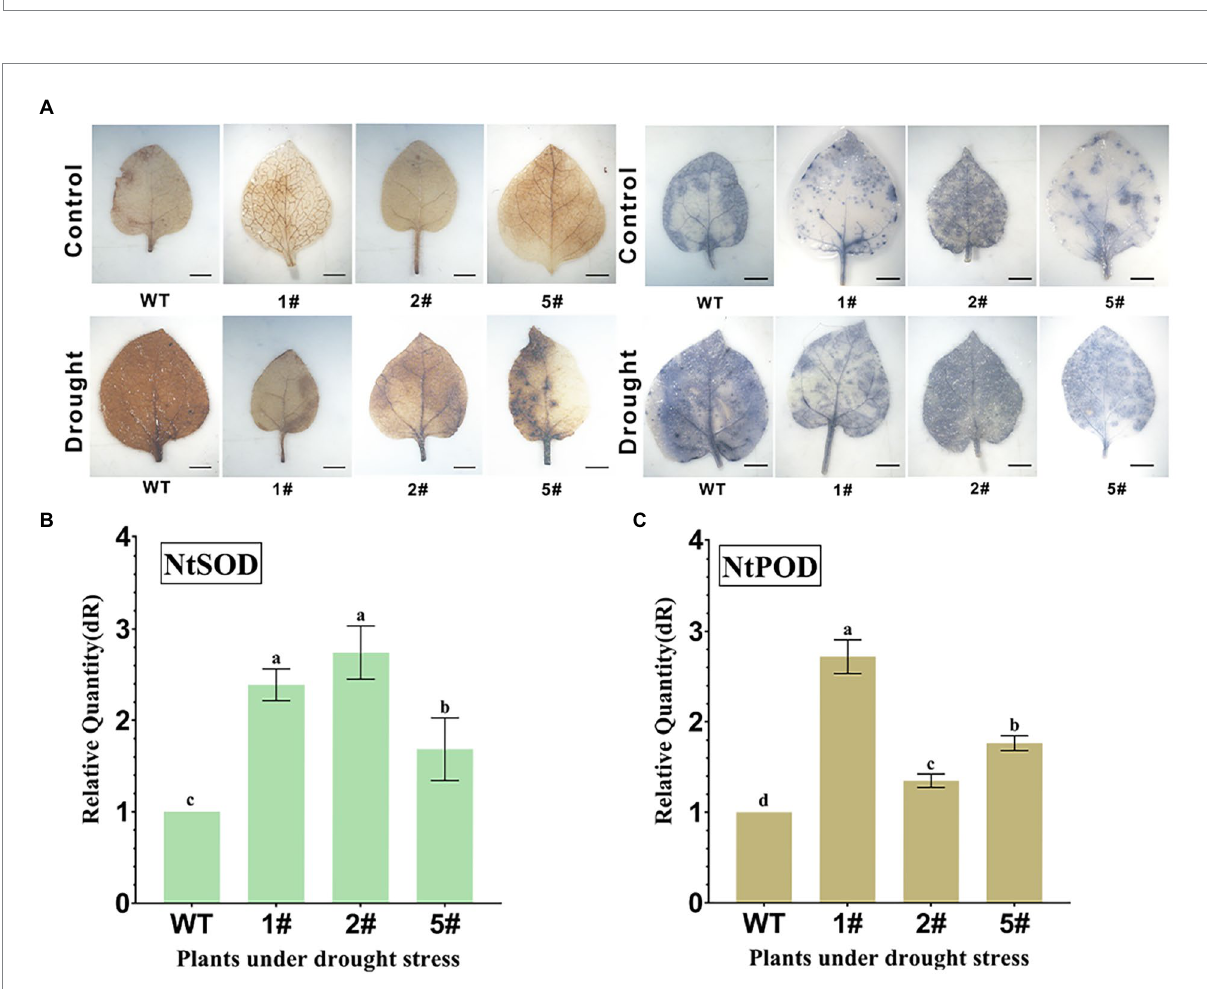
FIGURE 7 (A) Analysis of H 2 O 2 and superoxide anion in tobacco leaves under drought conditions. (B) Quantitative expression of NtSOD in real time under drought stress. (C) NtPOD quantitative expression in real time under drought stress. Error lines indicate standard errors of three biological replicates with significant differences at the p < 0.05 level. Bar, 2